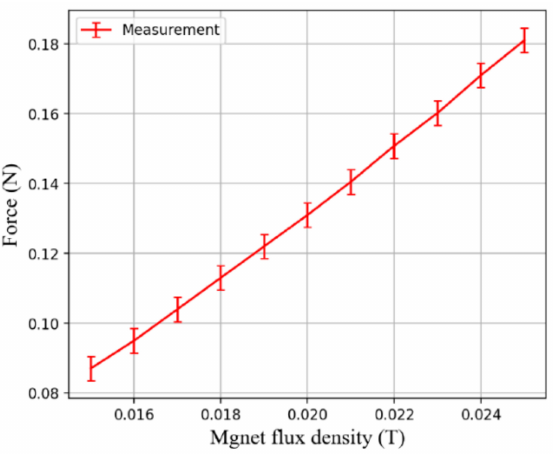
Figure 10. Experimental setup for measuring attraction force.